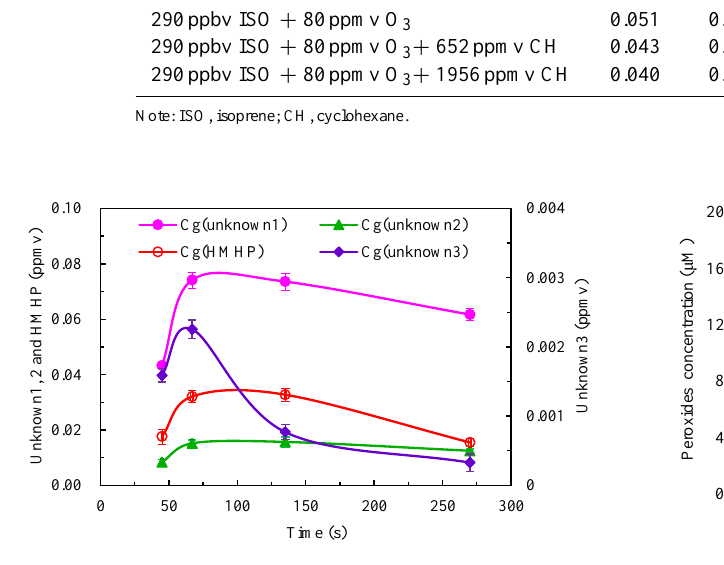
Table 1. The molar yields of the determined peroxides in the ozonolysis of isoprene in the presence and absence of the OH scavenger. Reactants